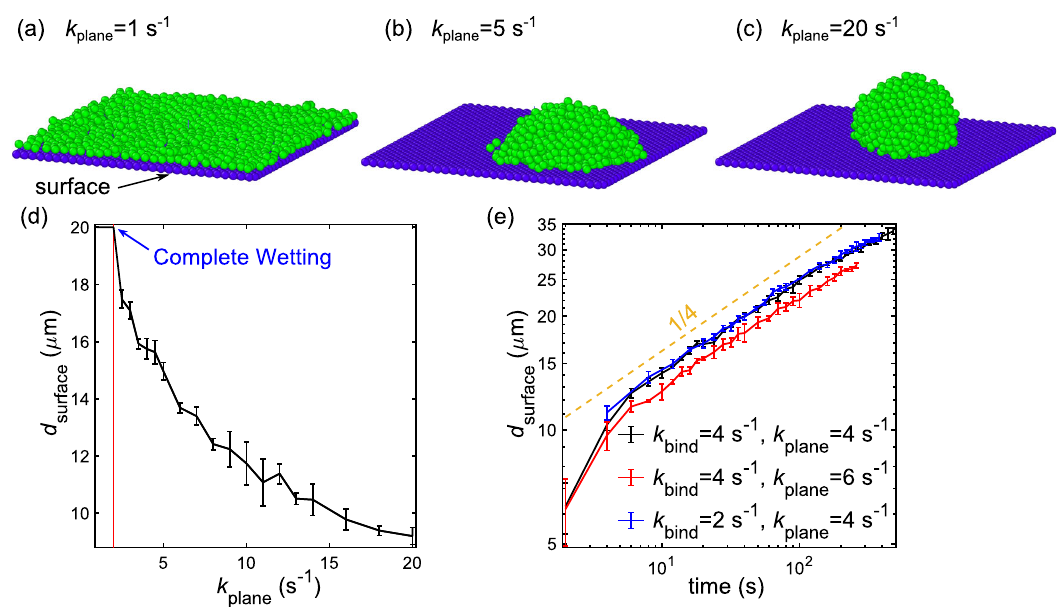
Fig. 6 Colony spreading on planar surfaces. a – c Simulation snapshots of spreading colonies. Depending on the dissociation rate constant of pilus-surface bonds, k plane , colonies undergo a partial or complete wetting transition. d A complete wetting occurs when k plane ≪ k rupt = 2 s − 1 . e The time dependence of the diameter of the spreading colony, d surface , obeys approximately a power law. If not given otherwise, pilus-substrate-binding rates and rupture forces are assumed to be the same as for pilus – pilus bonds, see Table 1. Error bars represent standard deviations from samples of three